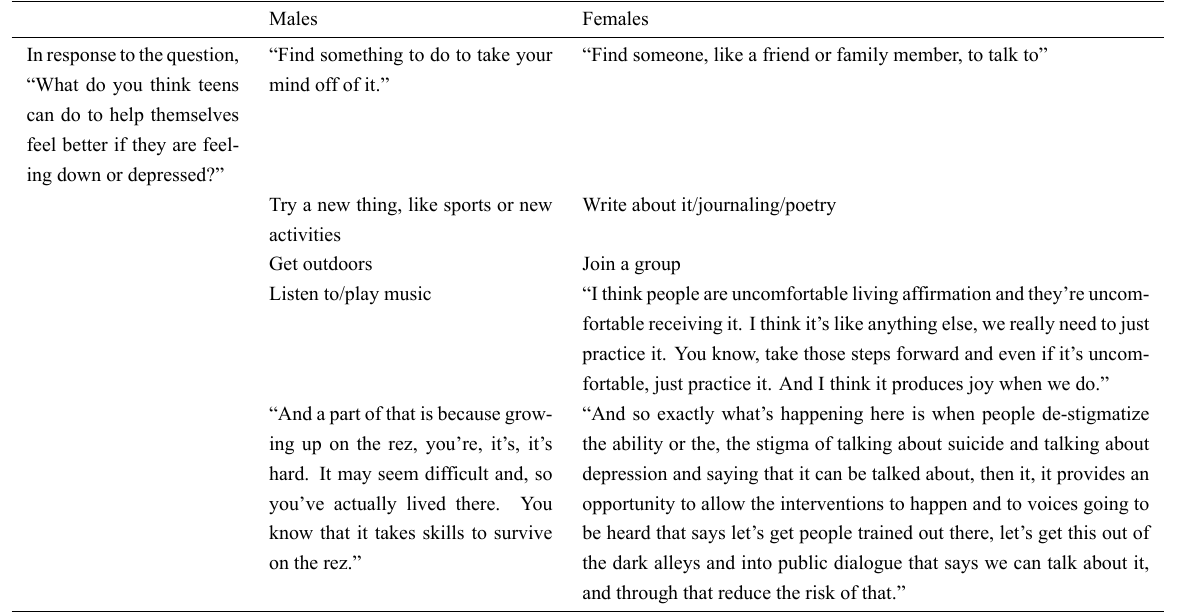
Table 6. Beliefs about effective coping